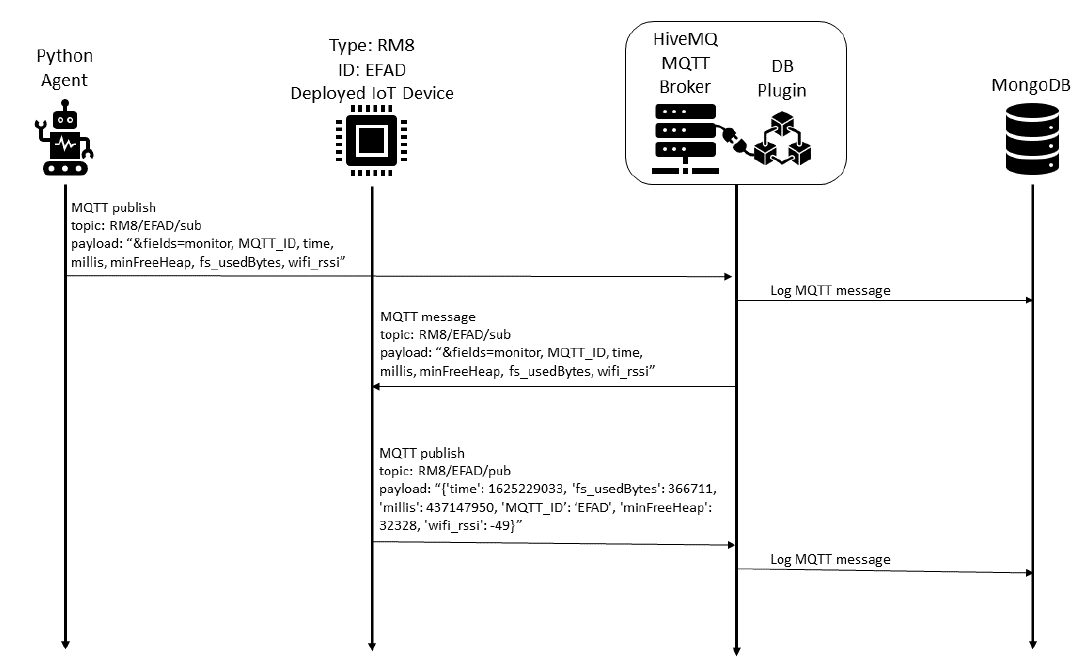
Figure 13. Deployed IoT device status data collection with periodic